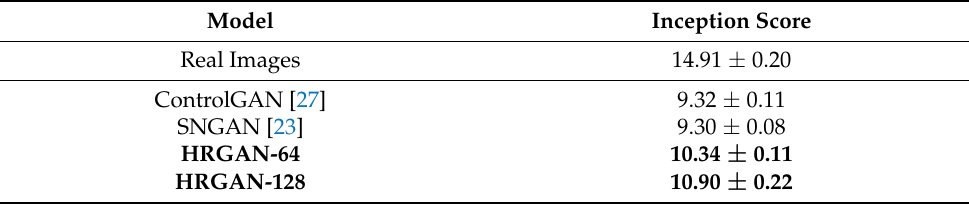
Table 4. The Inception scores of CIFAR100 dataset. The bold indicates the proposed